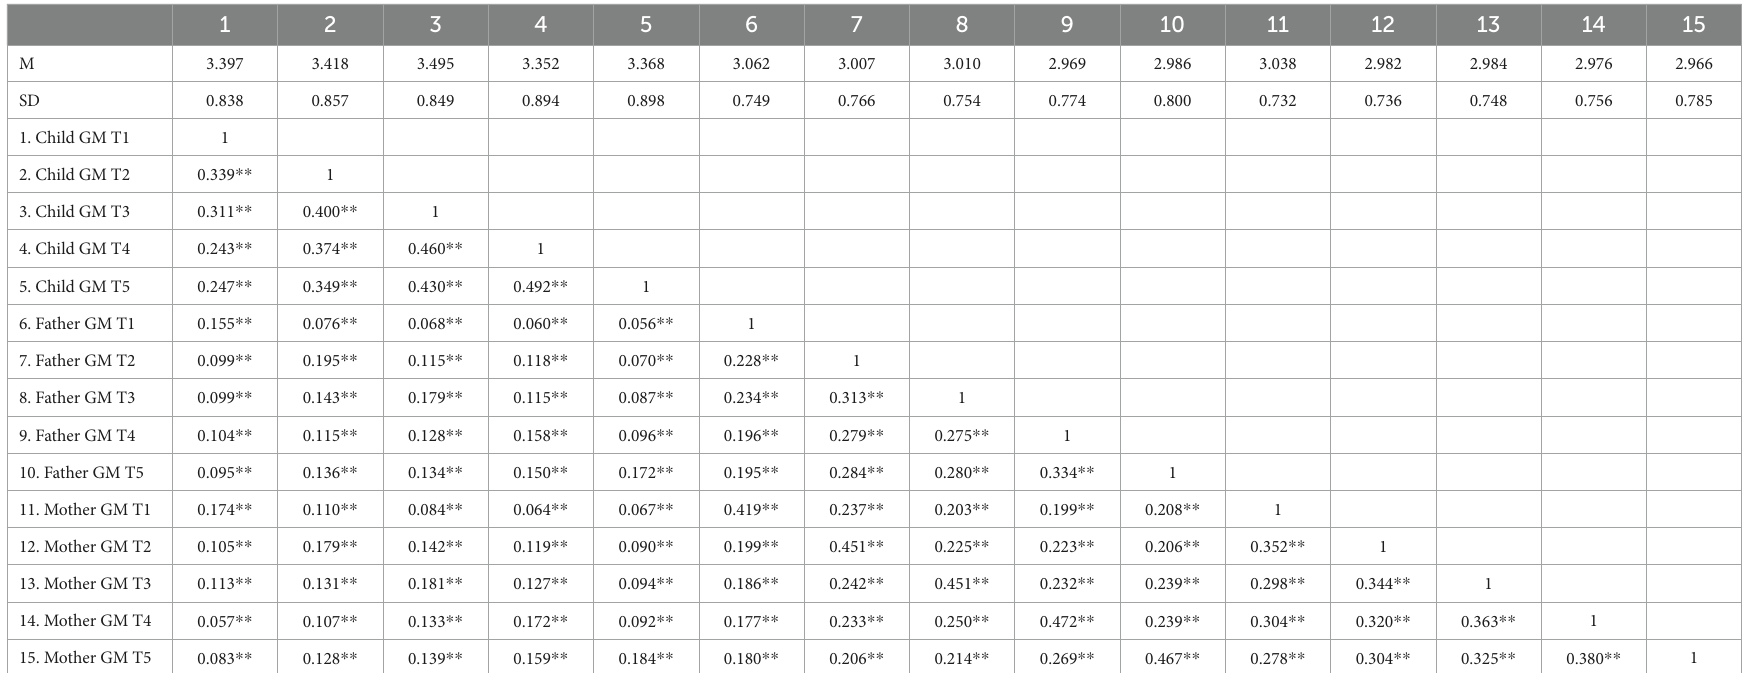
TABLE 1 Descriptive statistics and Pearson correlations for the main study